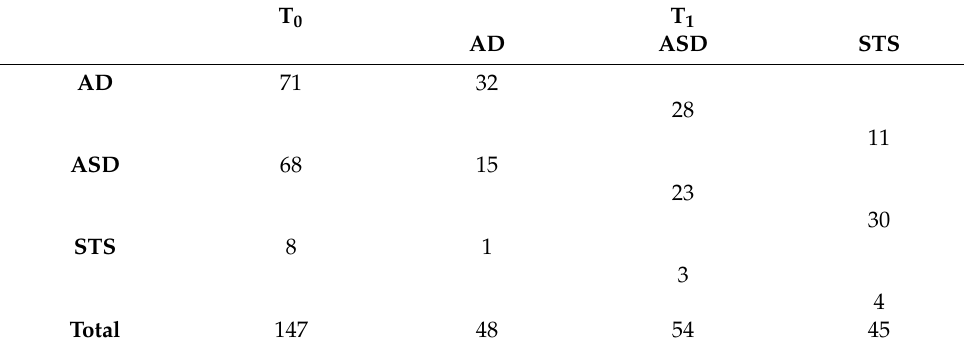
Table 2. Trend over time of the three diagnostic classes. T 0 T 1 AD ASD STS AD